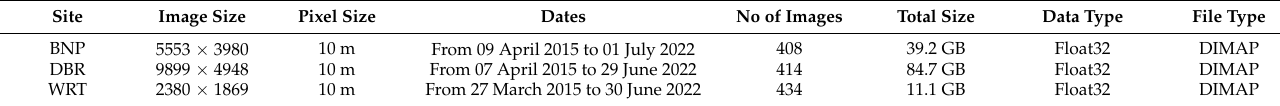
Figure 7. Representation of VH-bands for BNP, DBR, and WRT S1 image time series. Table 8. Main characteristics of the preprocessed datasets.